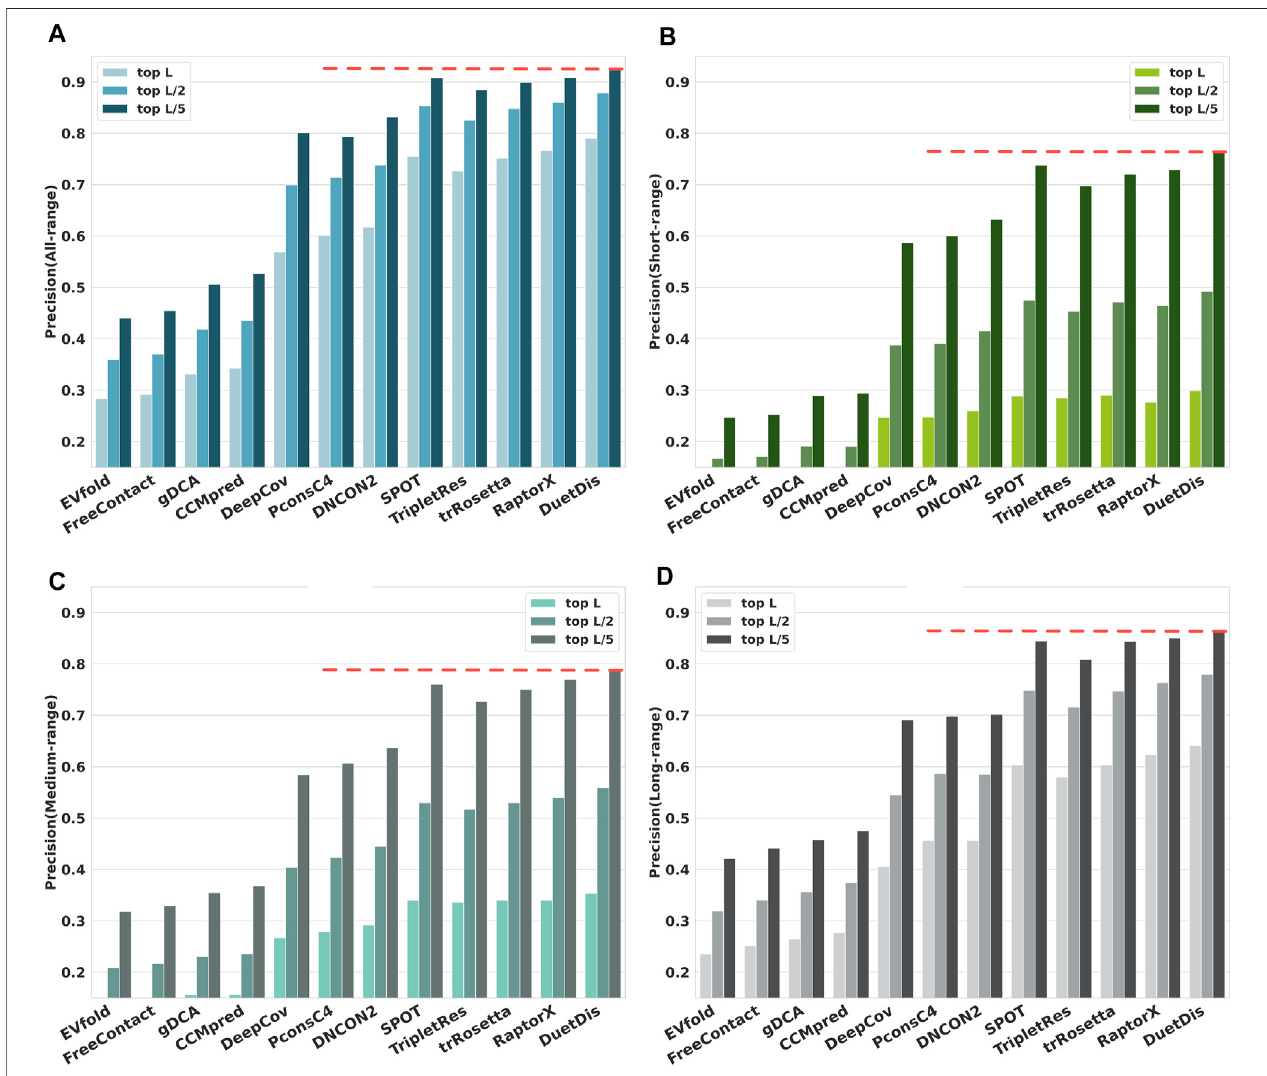
FIGURE 4 | The overall prediction precisions for (A) all-range, (B) short-range, (C) medium-range, and (D) long-range